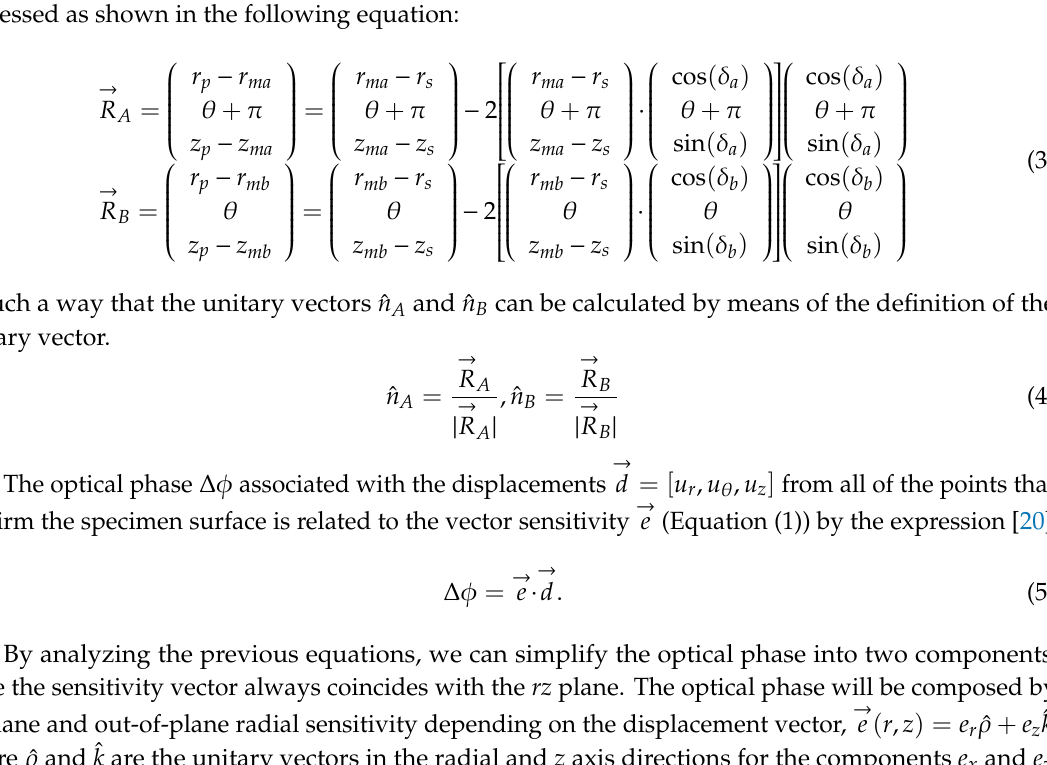
Figure 2. Reflection geometry for the calculation of the sensitivity vector with divergent illumination .